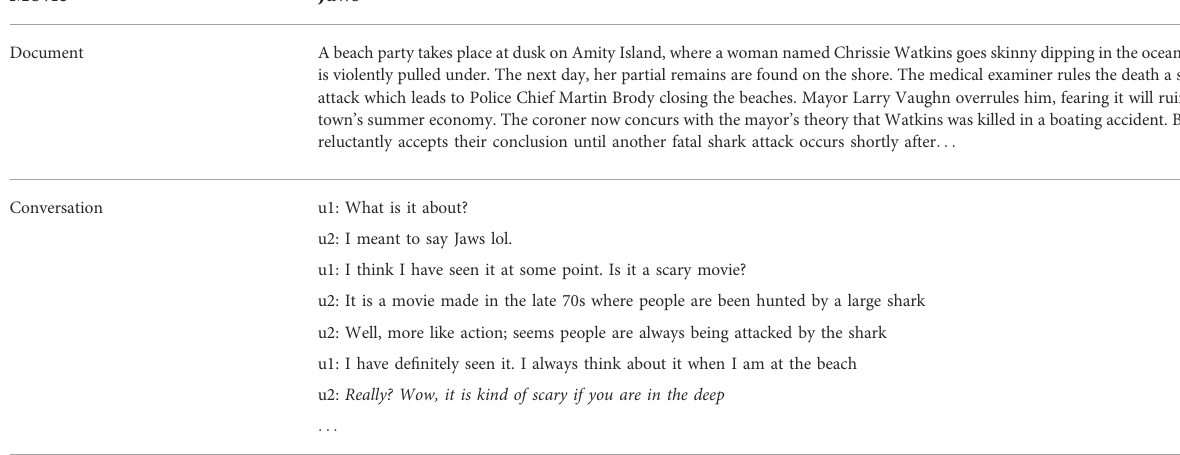
TABLE 1 Example in